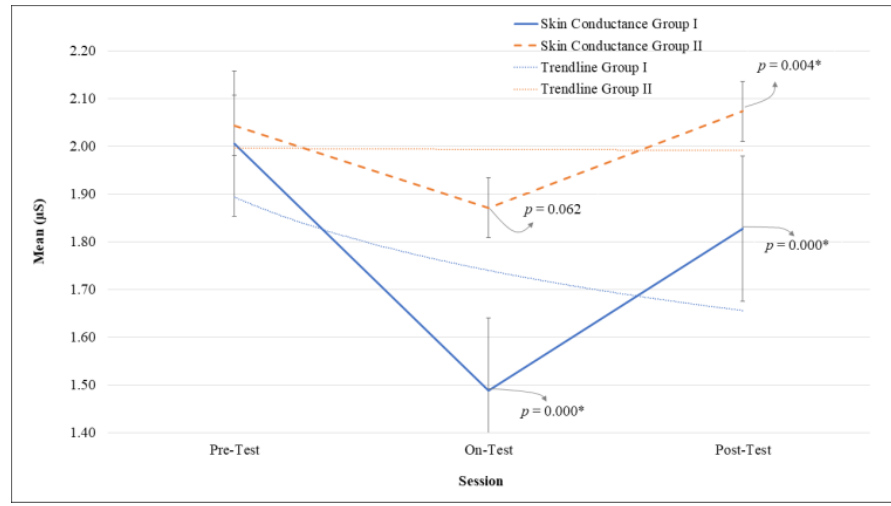
Figure 2. The alterations of skin conductance in group I and group II in pre, on, and post-test sessions. Data with * indicated the statistical difference in comparison to the previous session.